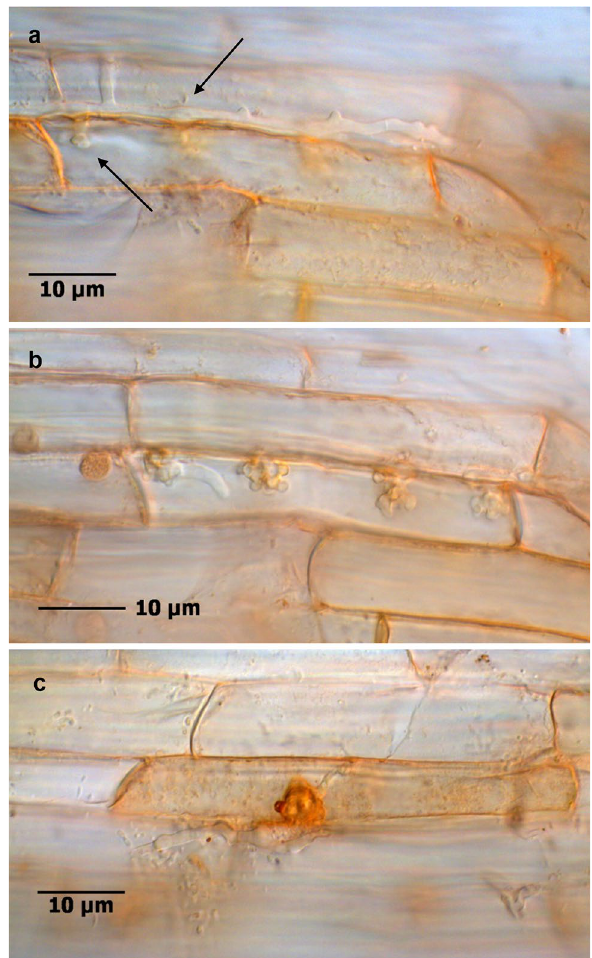
Figure 7. Fine root of R. corymbifera ‘Laxa’ with the infection of a CF structure forming fungus. Intraradical hyphae and cell penetration ( a , arrows), four intracellular CF structures and a connected growing hypha ( b ), and cell necrosis during penetration and CF formation ( c ). FUN®1 cell stain, bright field